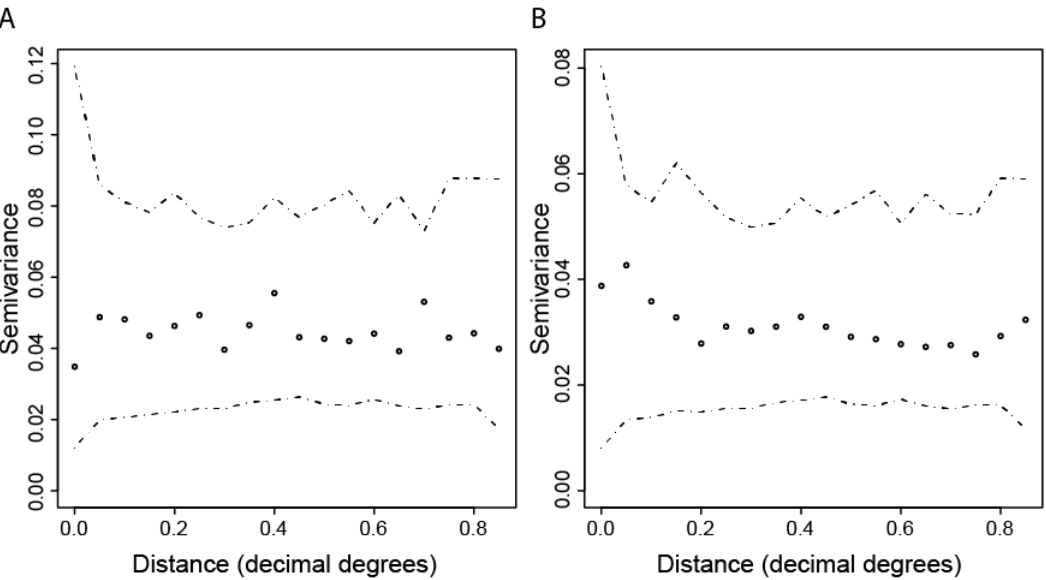
Figure A1. ( A ) Semivariogram of CHIKV village prevalence and ( B ) village random effects adjusting for log-transformed population density. Envelopes to assess significance of spatial dependency were computed by simulating 1000 permutations.